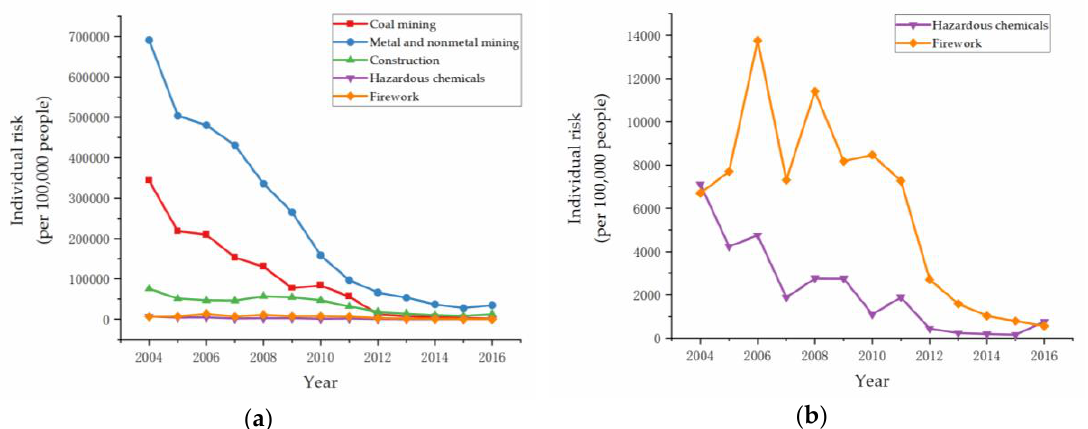
Figure 4. Individual risk of high-danger industries: ( a ) Coal mining, metal and nonmetal mining, construction, hazardous chemicals, and firework; ( b ) hazardous chemicals, and firework.